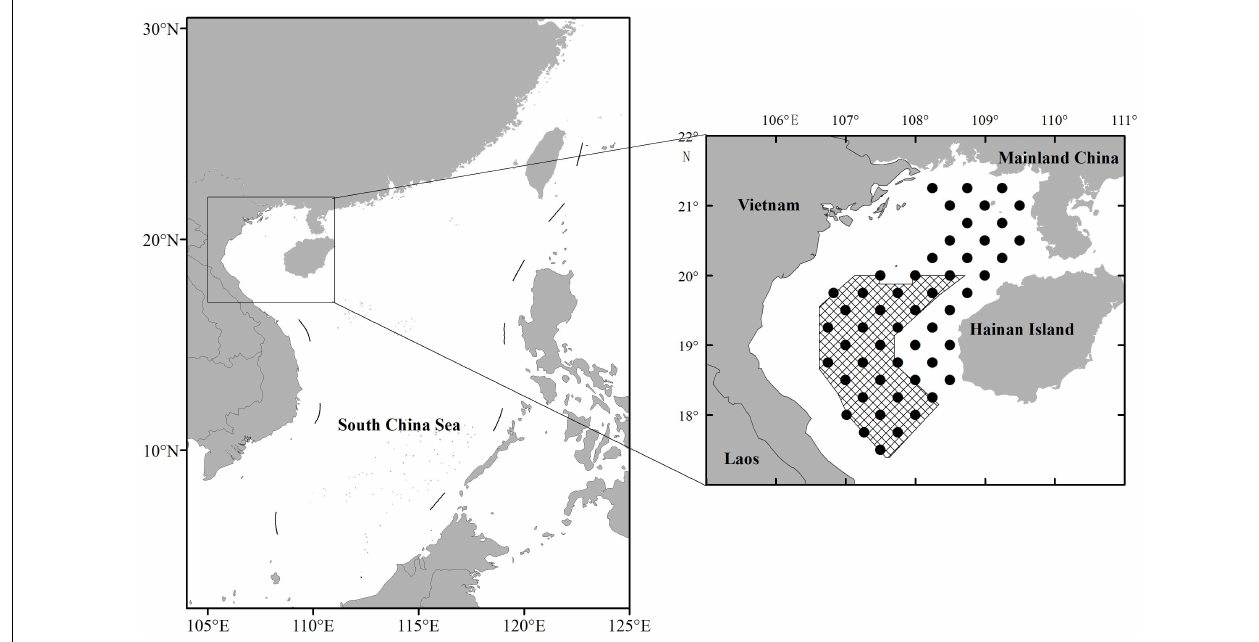
FIGURE 1 | Map of Beibu Gulf, including the joint fishing zone (grids) between China and Vietnam, and sampling stations